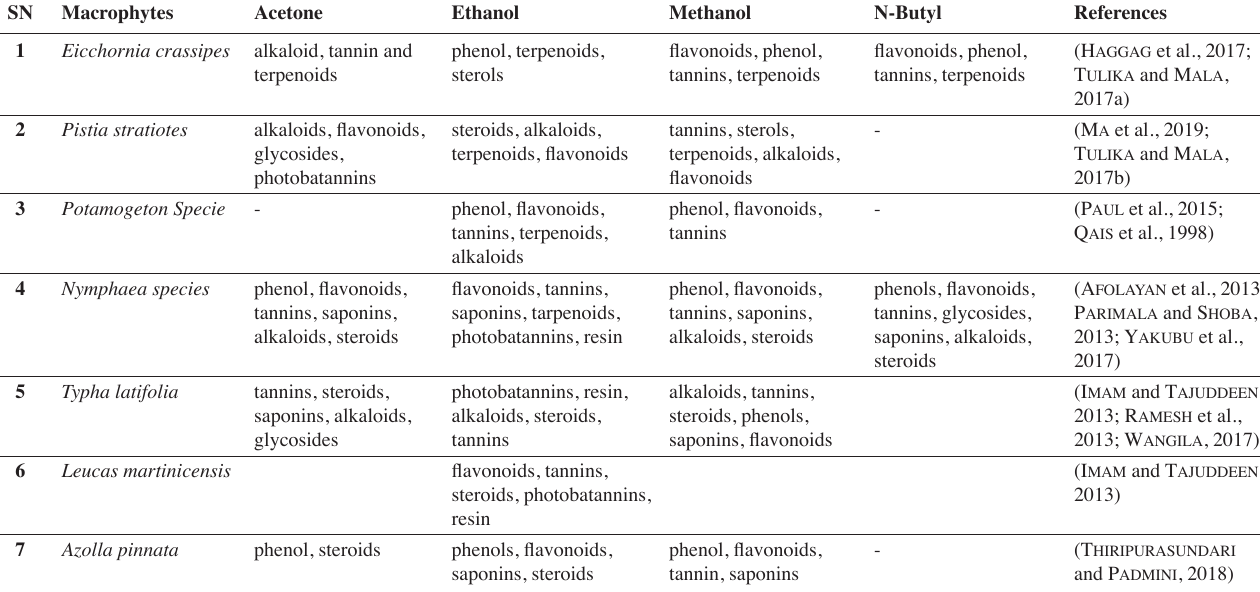
Tab. 2: Characterization of phytochemicals present in different leaves extract of